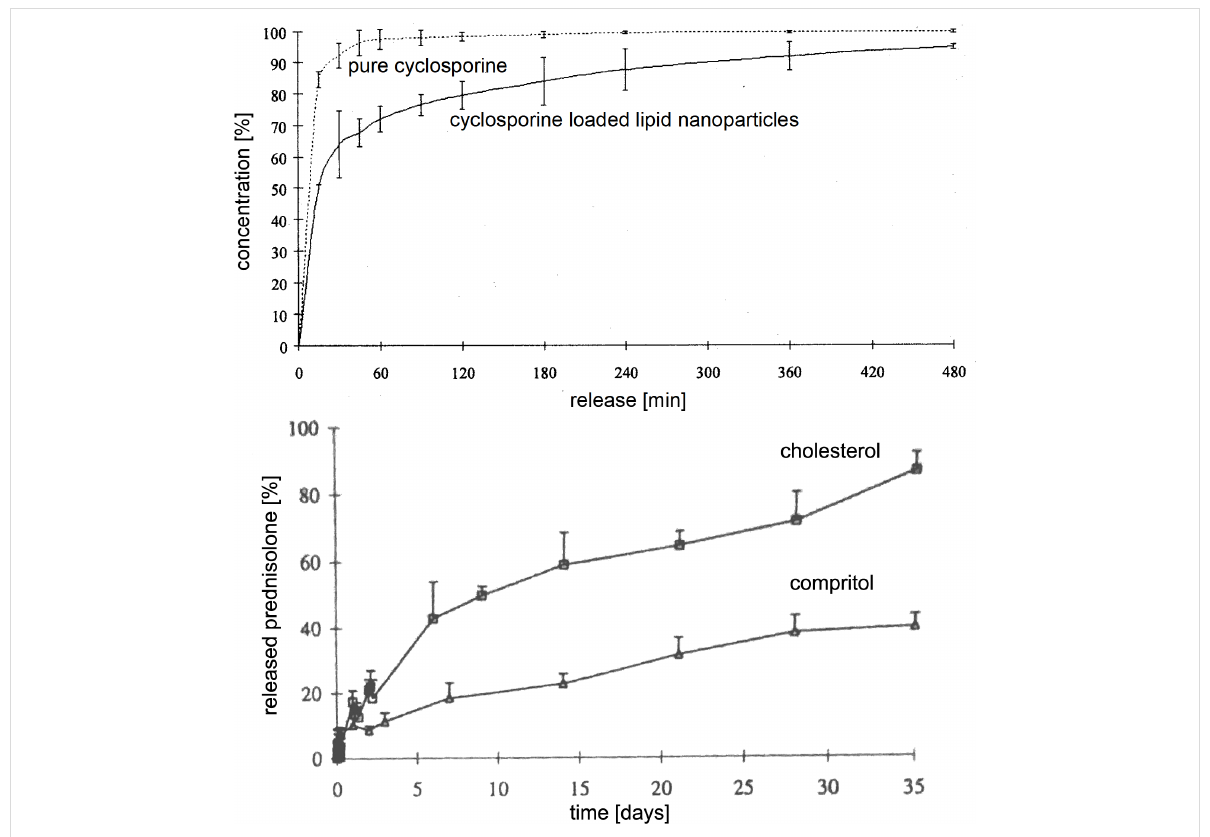
Figure 10: Examples of release profiles from lipid nanoparticles: very fast release of cyclosporine within minutes (upper row, after [35]), and the other extreme of very slow release of prednisolone over 35 days (lower row, after [36], explainable by enriched shell and enriched core model,